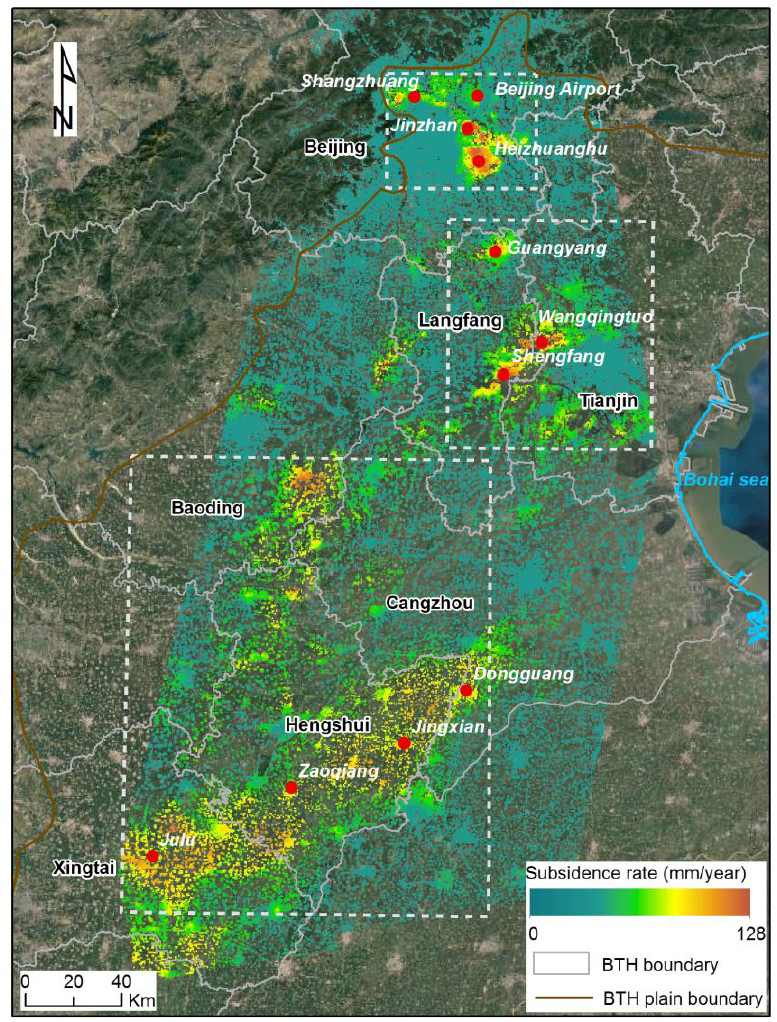
Figure 3. The average land subsidence rate from 2012 to 2018. The three white dotted frames are the main subsidence area in BTH, which we will discuss in detail in Figures